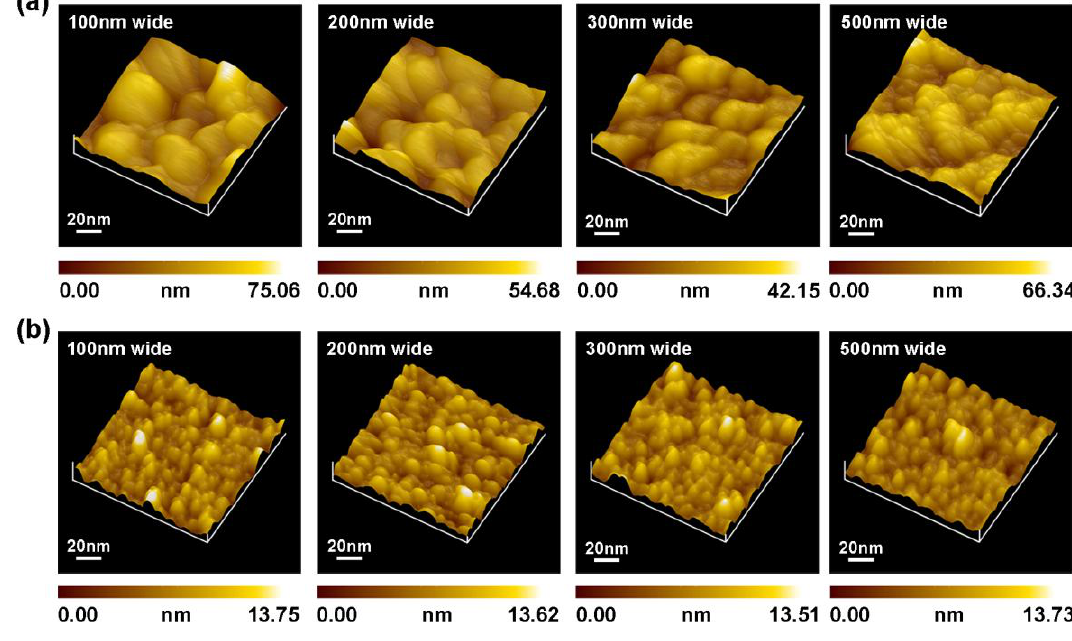
Figure 9. AFM images of the surface morphology for the  -APTES+NPs coated onto 100 nm-, 200 nm-, 300 nm-, 500 nm-wide PSW surface with UV illumination 120 s by (a) micropipette/spin-coating, and (b) C-AFM tip